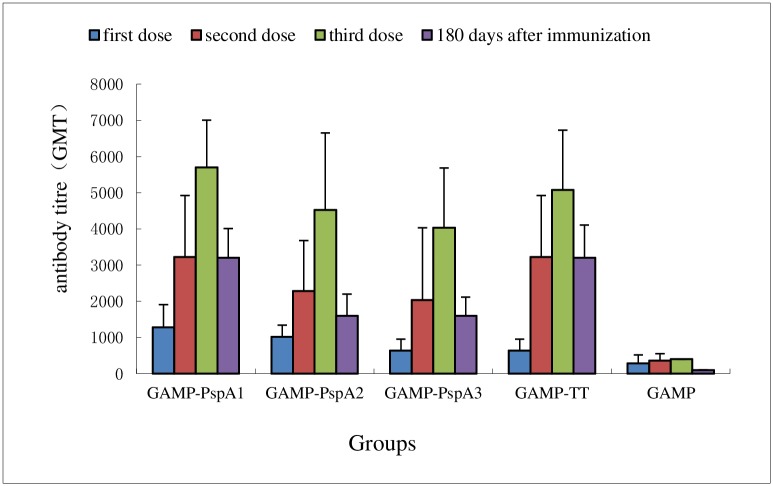
Results of anti-GAMP IgG antibody responses after the first, second, and third doses, and 180 days after the first immunization.The results were expressed as the reciprocal of geometric mean titer (GMT).